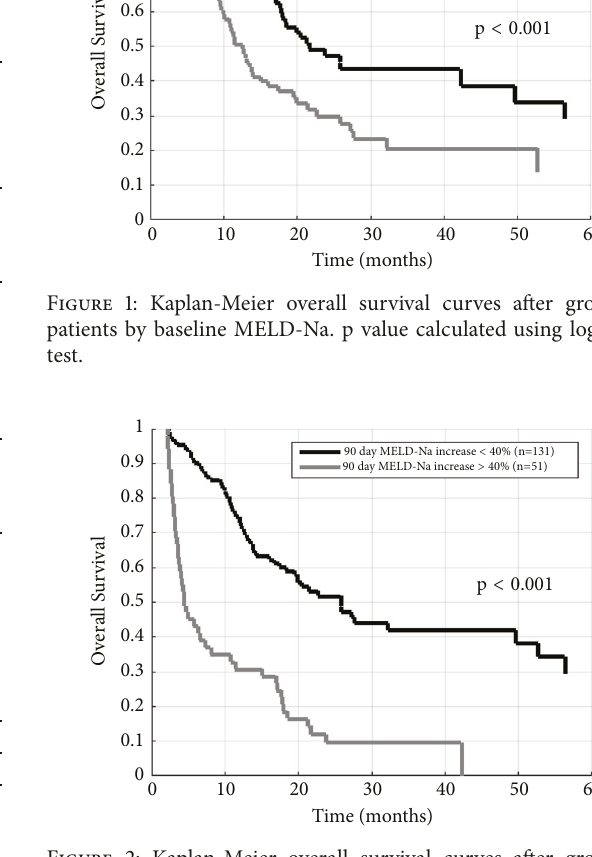
Figure 2: Kaplan-Meier overall survival curves after grouping patients using the optimal MELD-Na increasecutoff of 40%. p value calculated using log-rank